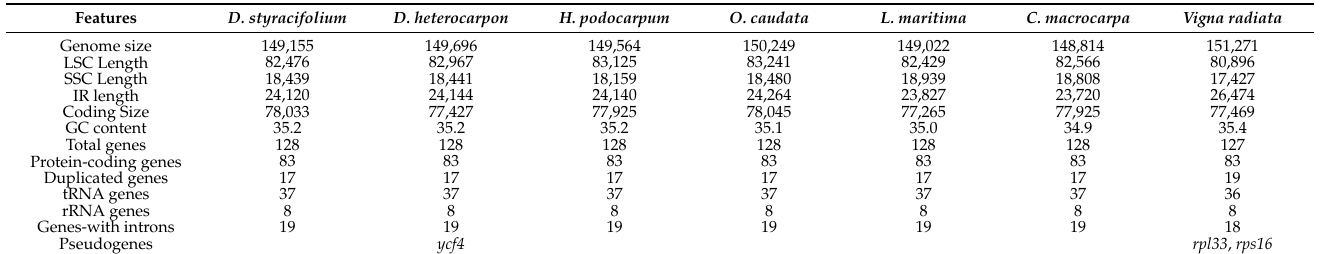
Table 1. Summary of the chloroplast genome features of six Desmodieae and an outgroup ( Phaselous vulgaris